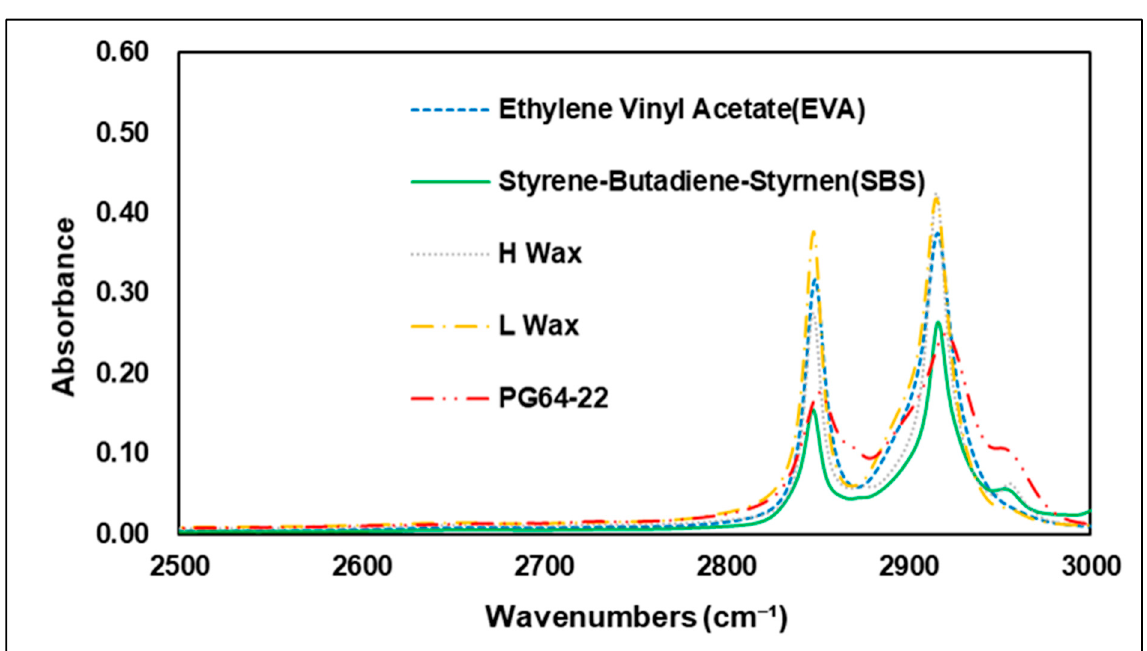
Figure 7. FTIR Spectrum of 1500–2000 cm − ¹ area.